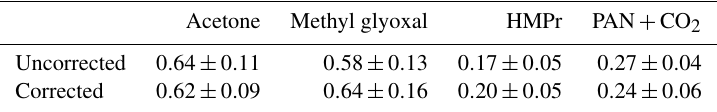
Table 5. Uncorrected and corrected molar yields of the 4M3P2 + OH system. Acetone Methyl